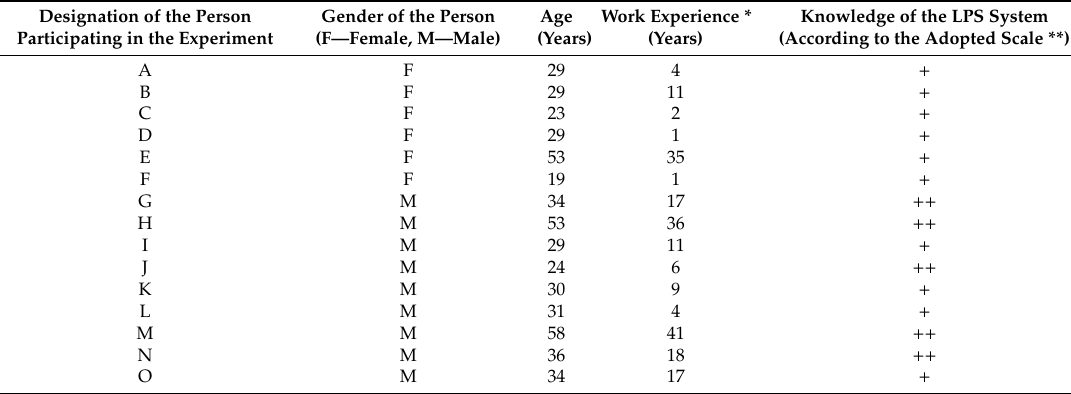
Table 1. Characteristics of people participating in field